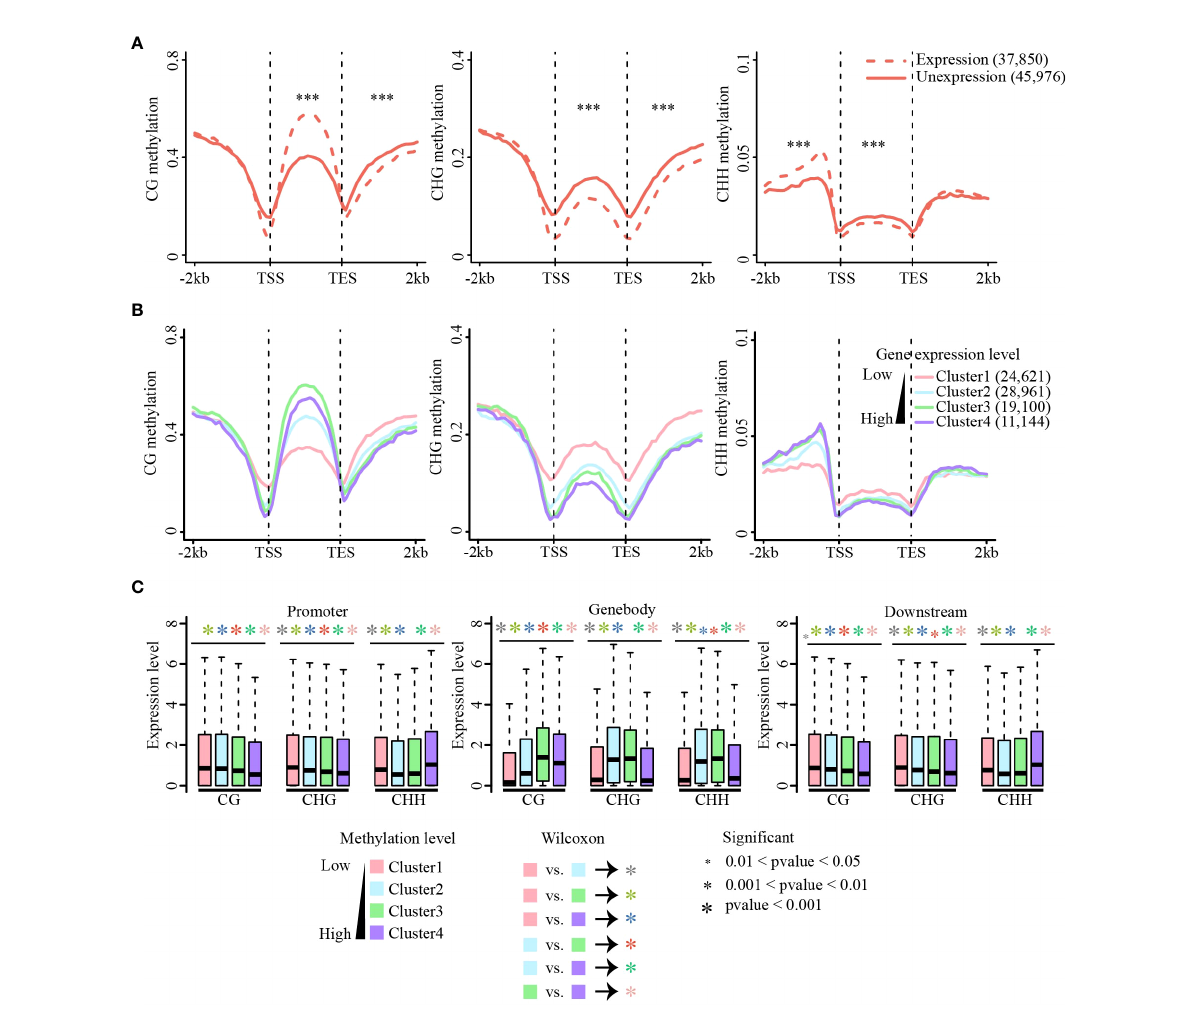
FIGURE 4 Association of methylation and gene expression. (A) Methylation level changes between the expressed and unexpressed genes in CG, CHG, and CHH sequence contexts. Methylation differences between expressed and unexpressed genes were tested using the Wilcoxon rank-sum test. ***p-value < 0.001. (B) Correlations between methylation levels (CG, CHG, and CHH) and gene expression across gene body and fl anking regions. Methylation level of each gene group [Cluster1 (FPKM = 0), Cluster2 (0 < FPKM ≤ 2), Cluster3 (2 < FPKM ≤ 10), Cluster4 (FPKM ≥ 10)] were calculated. CG (left), CHG (middle), and CHH (right). (C) Expression levels of methylated genes in the gene body and fl anking regions. Genes were divided into four quartiles based on methylation levels, from the fi rst quartile (the lowliest methylated 25% of genes) to the fourth quartile (the most highly methylated 25% of genes). Expression differences between different clusters were tested using the Wilcoxon rank-sum test. The colors of the asterisk (*) represent the comparison between different clusters, and the size of the asterisk (*) indicates the criterion of signi fi cance. (A – C) are data in leaf